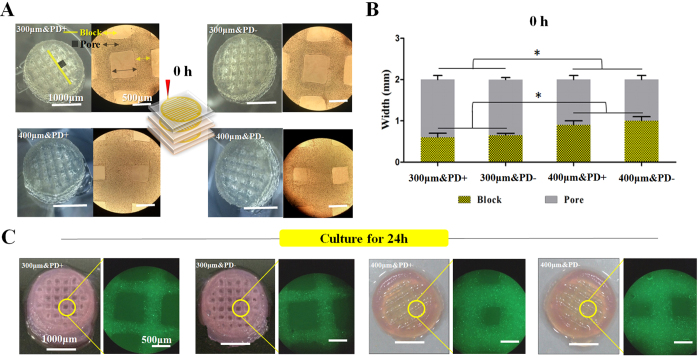
Characteristics of printed porous constructs.(A) Two typical architectures of the porous construct, block and pore, identified right after printing. (B) Width of block and pore between 300- and 400-μm–printed constructs at 0 hr. Data are mean ± SD. *P < 0.05. (C) Embedded cell distribution and structural stability of printed constructs after 24-hr culture. (scale bar: 1000 μm for macroscopic images; 500 μm for microscopic images).